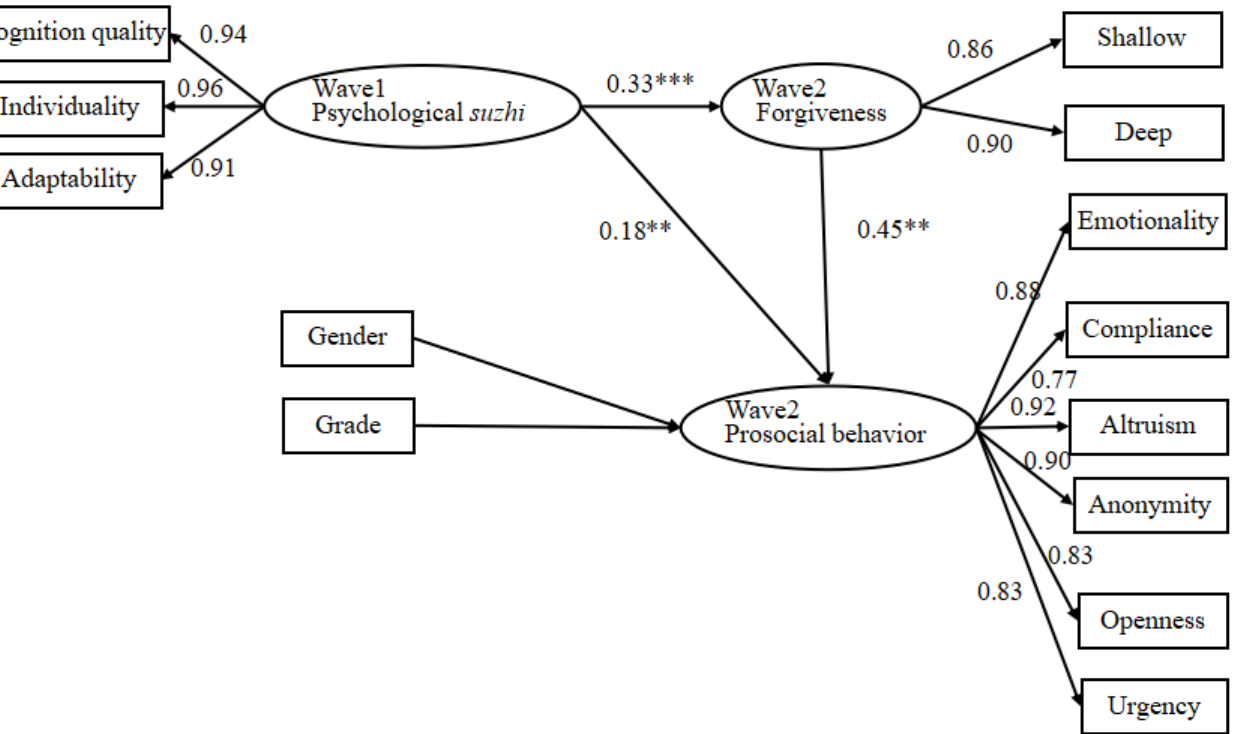
Figure 1. Structural Equation Model of the Continuous Effect of Psychological Suzhi on Prosocial Behavior in Wave 2 ( ** p < 0.01, *** p < 0.001).